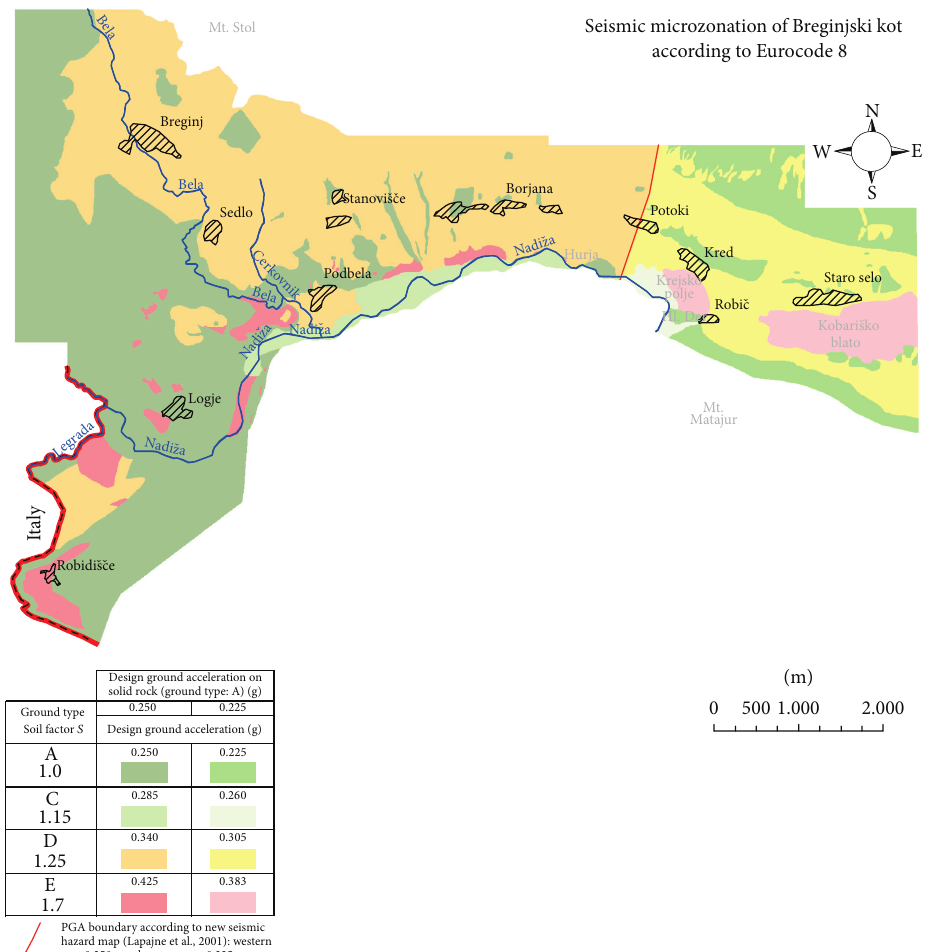
Figure 6: Eurocode 8 seismic microzonation of Breginjski